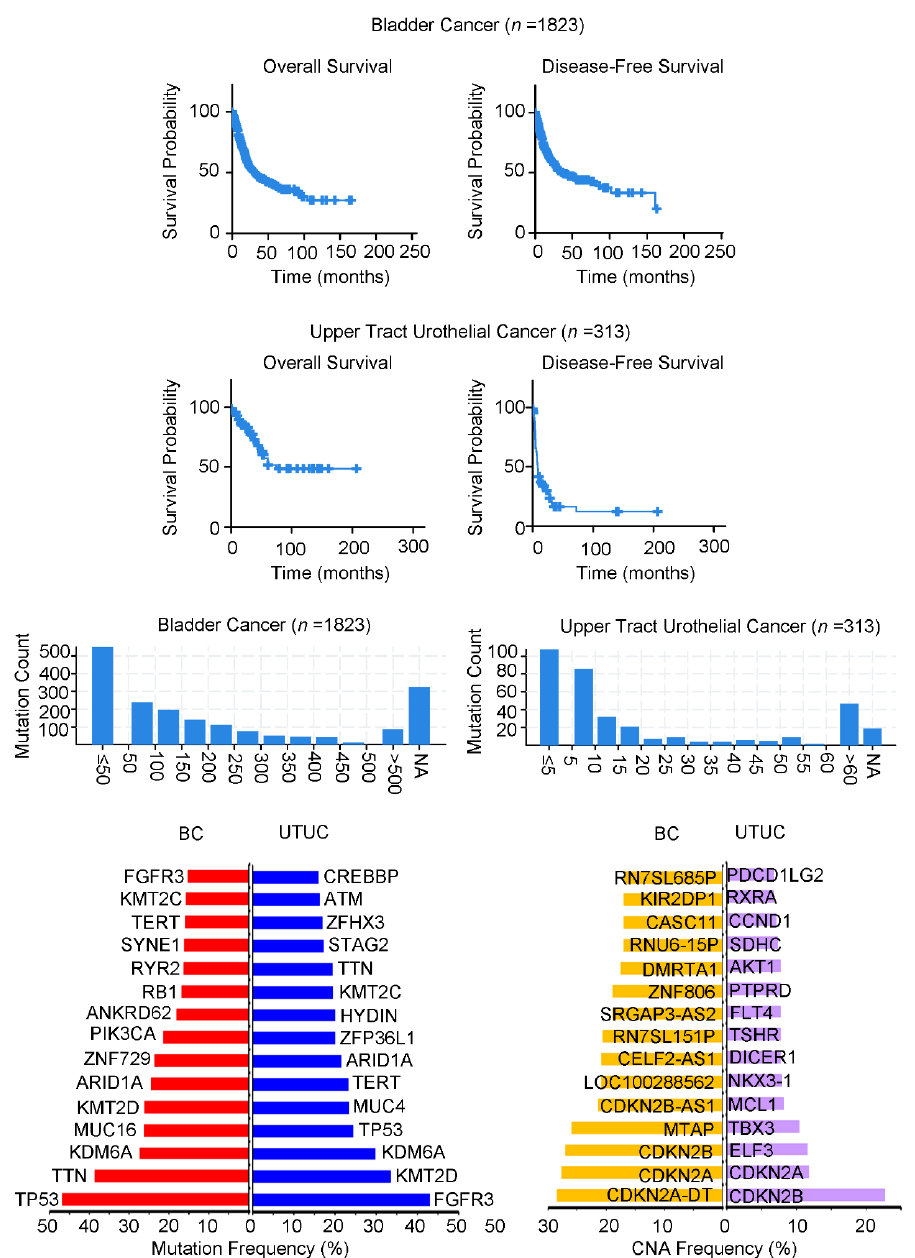
Figure 1. A meta-analysis of BC ( n = 1823) and UTUC ( n = 313) cohorts to reveal the survival rates, mutation frequency, and genetic alterations of clinical patients. The overall survival of BC (average 32 months) is worse than UTUC (average 60.79 months), but the disease-free survival rate of UTUC (average 8.5 months) is worse than BC (average 35.3 months). In addition, the TOP15 gene alterations and CNA changes of the two cancers are mostly different, with only a few repetitions but different frequencies. Genetic background and clinical parameters in urothelial cancer. All data were analyzed from the cBioportal website. CNA: copy number alteration.